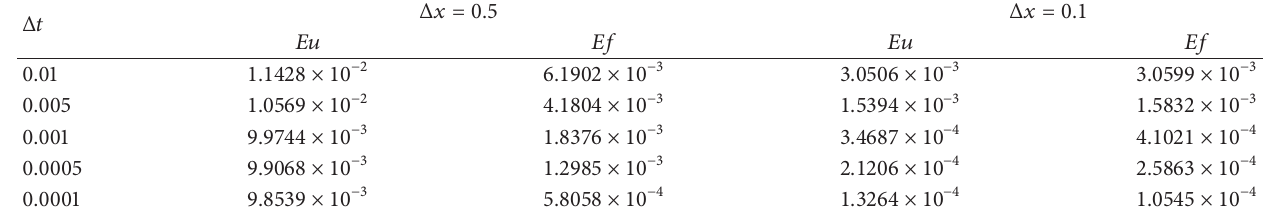
Table 1: The errors for different Δ𝑥 and Δ𝑡 .